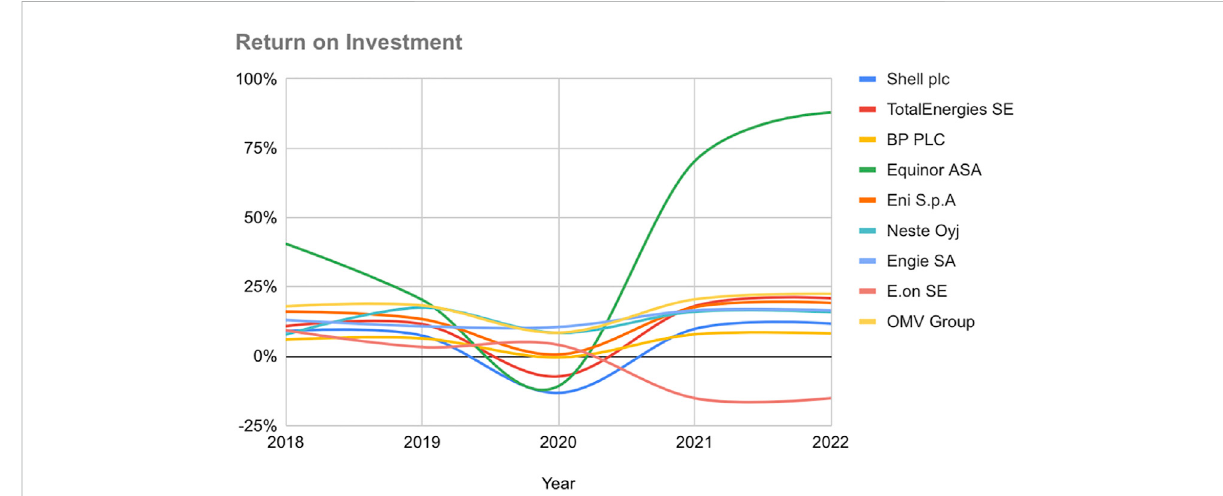
FIGURE 4 Line chart: Return on investment. Source: Own elaboration.